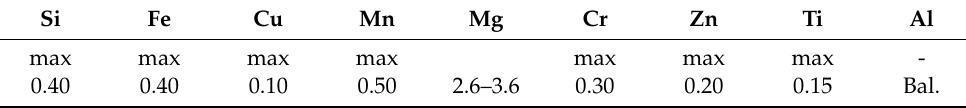
Figure 1. The outer design of the transferable capsule used for teleperformance assessment tests and telerehabilitation: ( a ), schematic of the outer elements, and ( b ), locations of corrosion tests. Table 1. The chemical composition of 5754 alloy in mass%